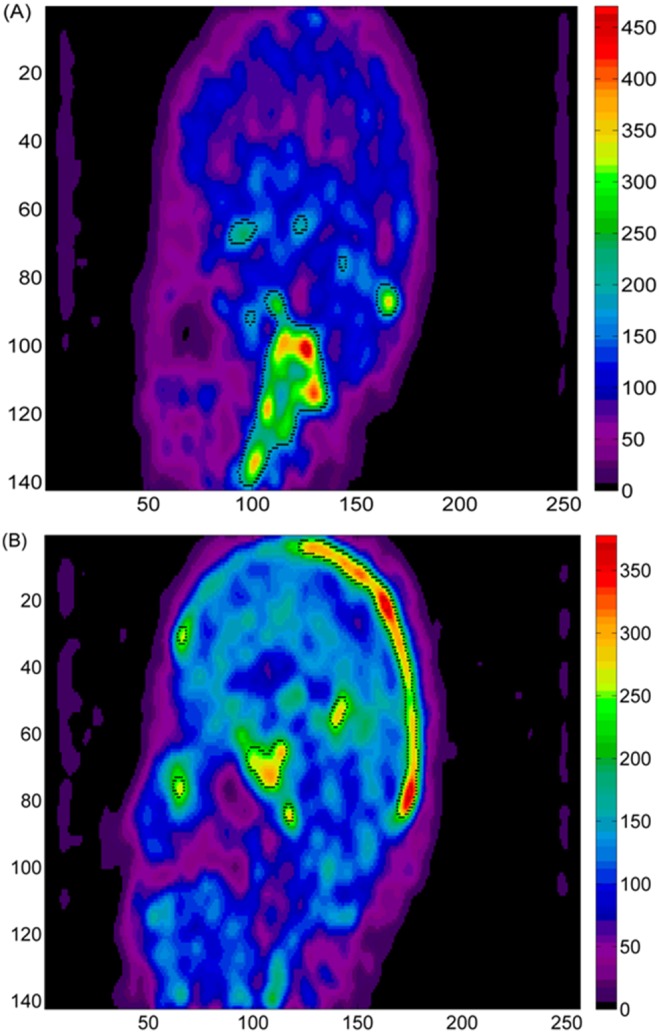
ROIs extracted for the ICA algorithm for the same subject in Fig. 1.Binary masks were created from the time-averaged image (first 10 frames) and applied onto each plane to automatically select the whole-brain blood regions over all planes. A) depict the arterial activity. B) depict the superior sagittal sinus.